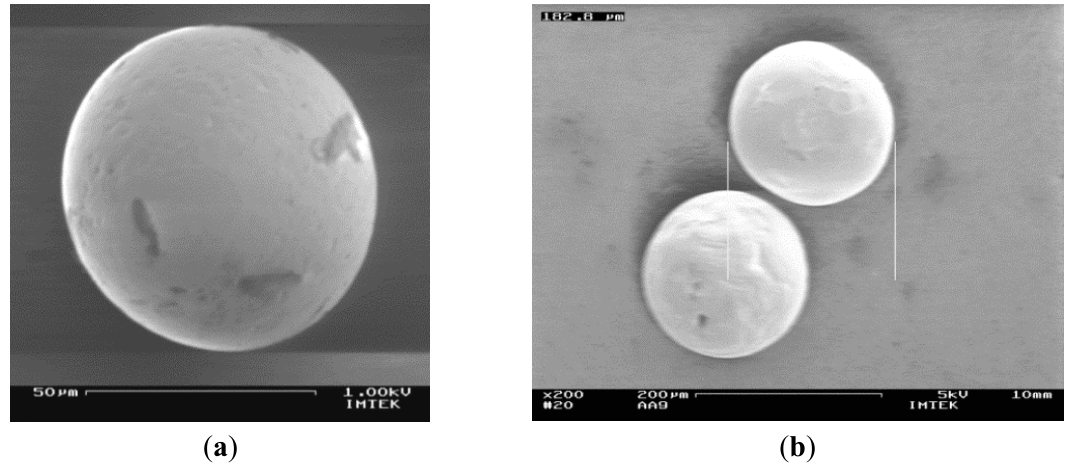
Figure 12. ( a ) SEM image of metal (solder: Sn95Ag4Cu) droplet dispensed into soar water with diameter of D = 60 μ m. ( b ) SEM image of dispensed metal (ZAMAK: Zn96Al4) droplets with diameter of D = 180 μ